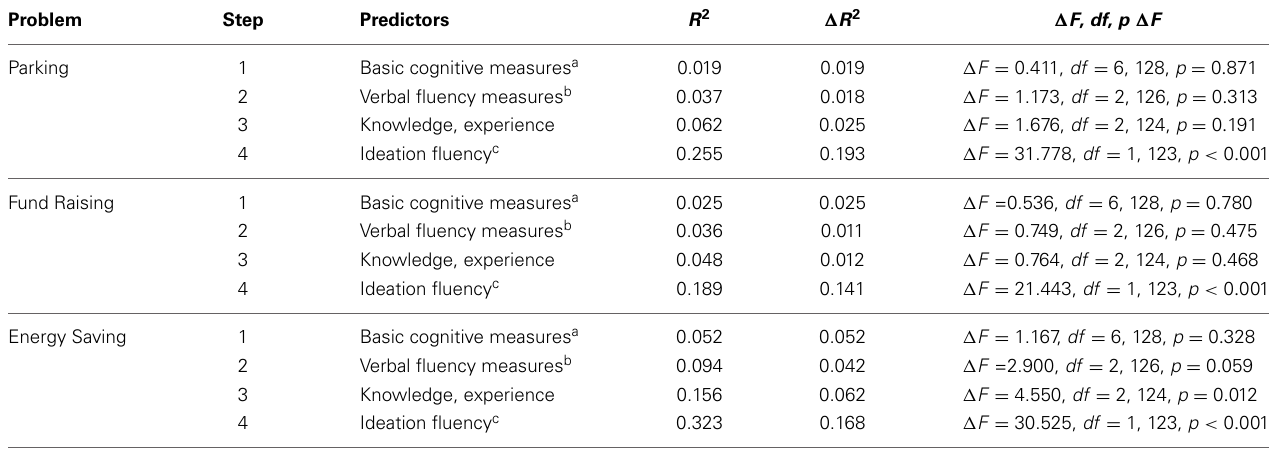
Table 1 | Hierarchical regression results.